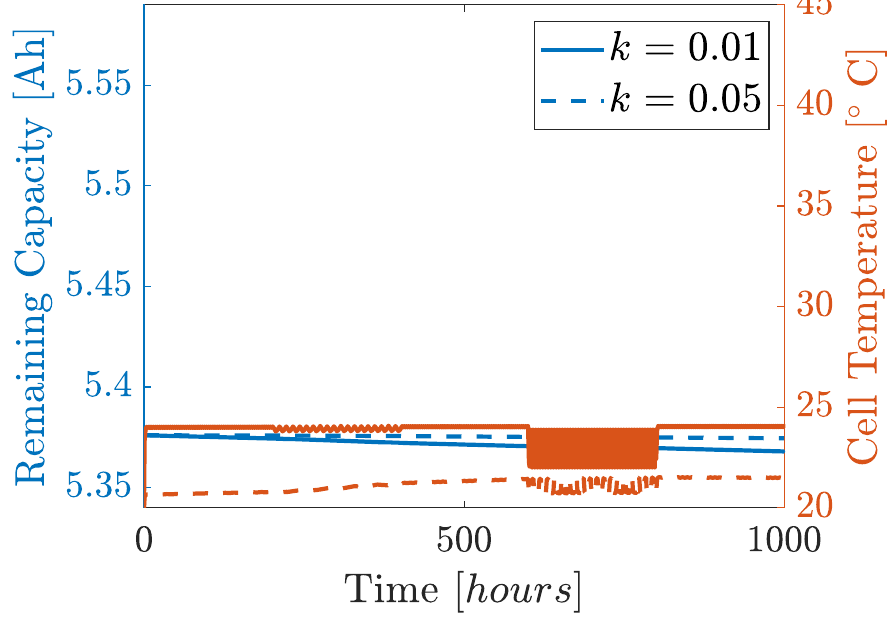
Figure 16. SoH: Effect of the gain k on Battery